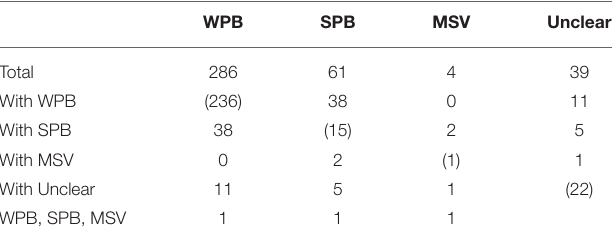
TABLE 3 | Number of LE days with each morphological cloud type during the study period.